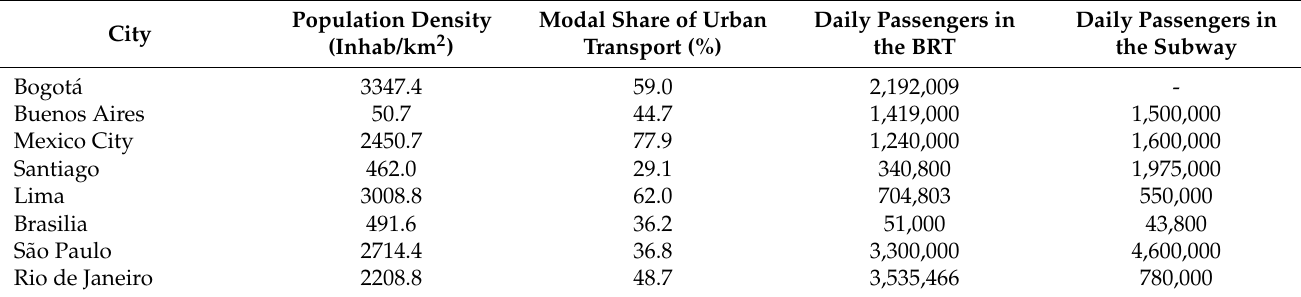
Table 2. Data on population density in the metropolitan area, the modal share of urban public transport and the number of daily passengers served in the BRT and subway systems of the cities under